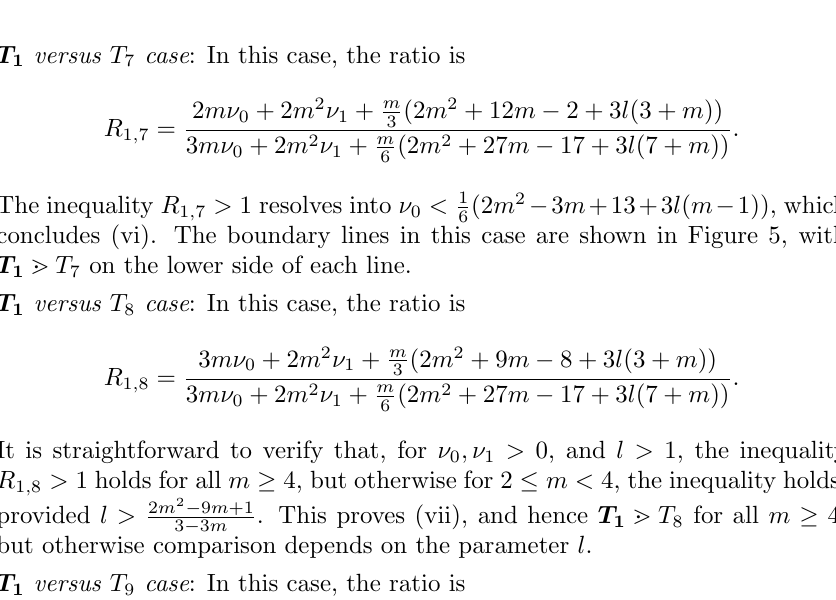
Figure 4. Boundary lines for comparison of T 1 and T 6